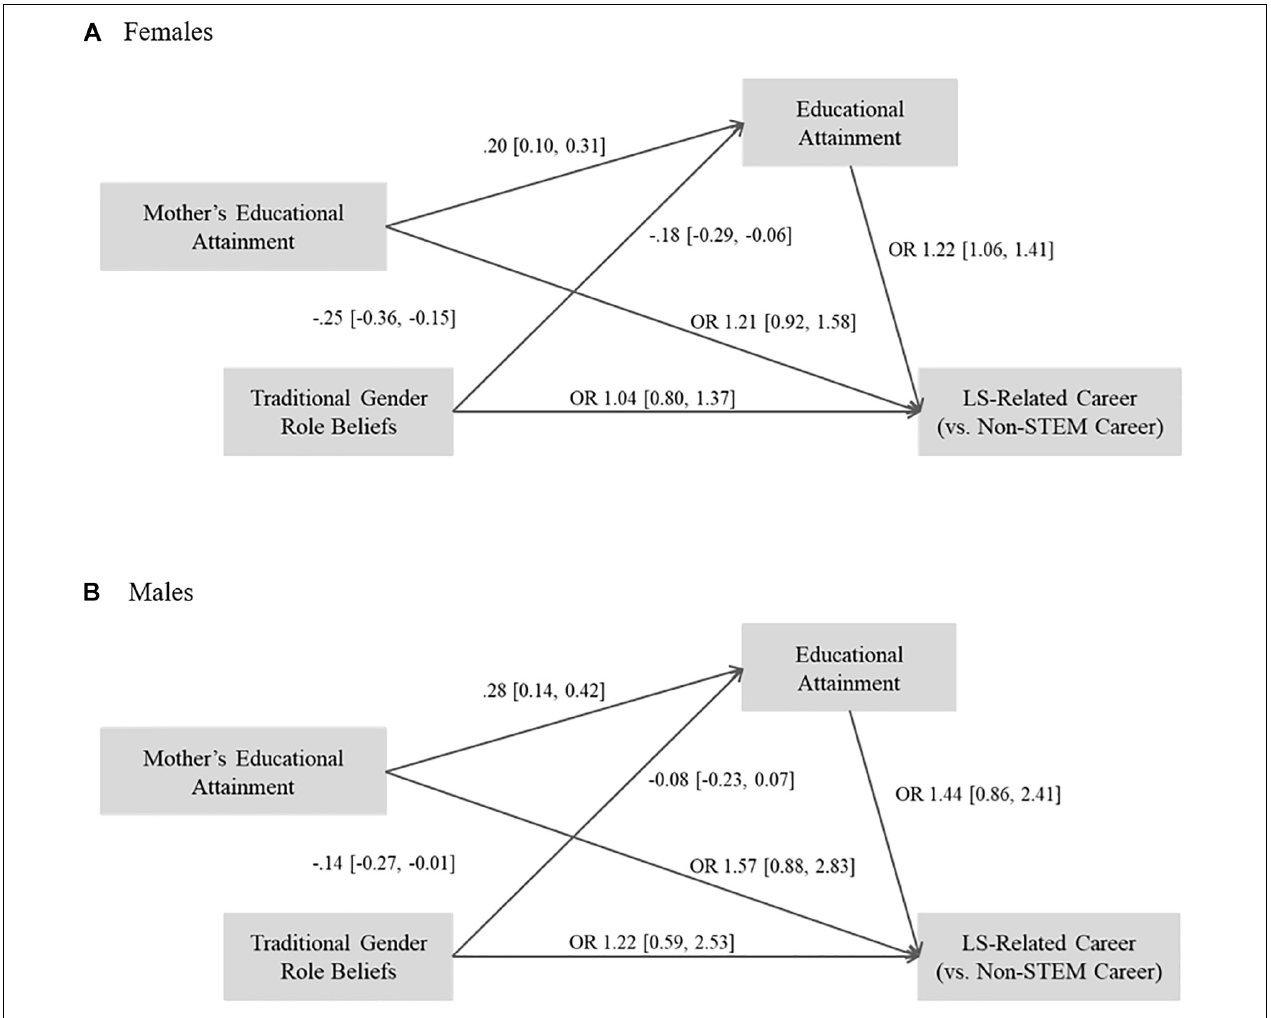
FIGURE 2 | Results of multi-group path analyses by gender for LS-related careers vs. non-STEM careers. (A) Results for females and (B) results for males. Standardized coefficients are shown for continuous variables. OR, Odds Ratio. 95% Confidence intervals in brackets. Confidence intervals excluding 0/1 for regression coefficients/odds ratios indicate statistical